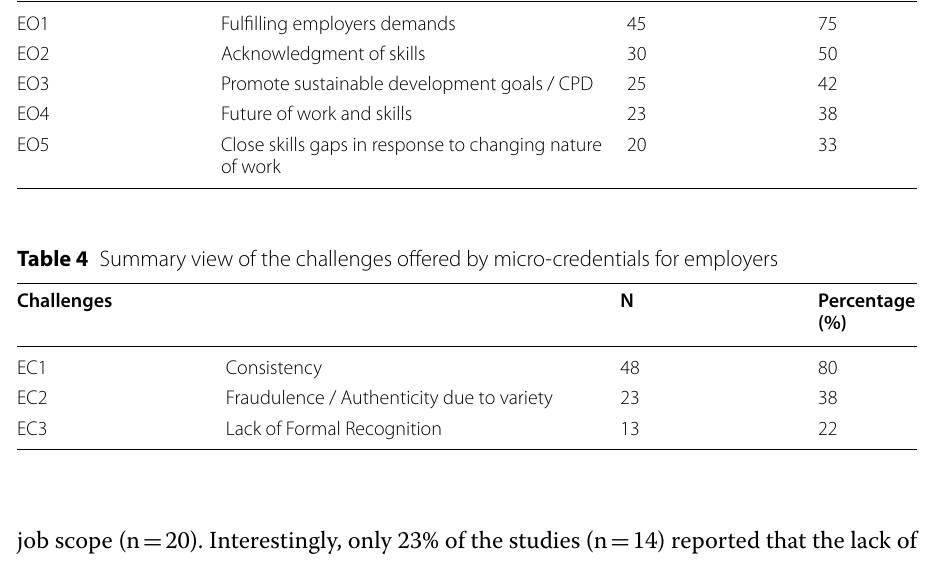
Table 3 Summary view of the opportunities offered by micro-credentials for employers Opportunities N